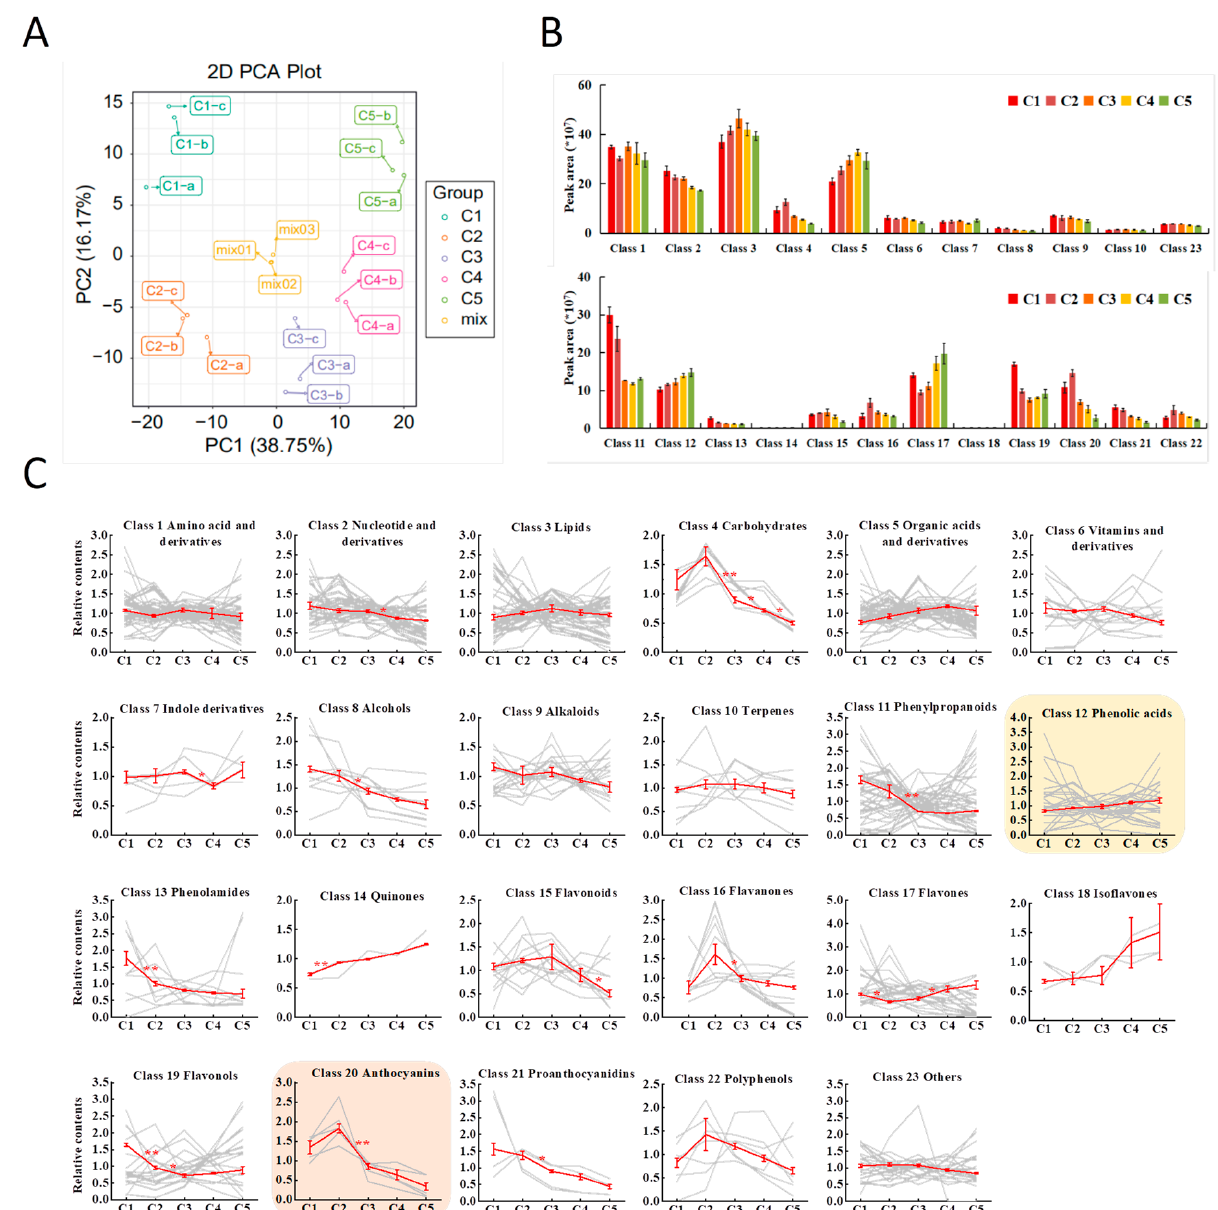
Figure 2. Metabolite accumulation for the 23 classes in leaf stages from C1 to C5. ( A ) PCA analysis of the 449 identified metabolites. Mix 01–03 were the three quality control samples. ( B ) Metabolite abundance of the 23 classes indicated by the added-up peak areas of compounds within each class. ( C ) Relative accumulation trends for compounds of the 23 classes. The trends were reflected by standardized peak areas (mean peak area of each stage/mean peak area of the five stages). Each gray line represents the trend for one individual compound. The red lines represent the combined trends of the compounds from each class. Class 12 (Phenolic acids) and Class 20 (Anthocyanins) were high- lighted by yellow and pink shades, respectively. All values are expressed as means ± SE, n = 3. The significant differences for adjacent stages are indicated by asterisks at p < 0.05 (*) and p < 0.01 (**). Relative accumulation trends for metabolites of the 23 classes were shown by stand- ardized peak areas (mean peak area of each stage/mean peak area of the five stages) (Fig- ure 2C). Within each class, the general trend (shown by the red line) was the same as that in Figure 2B, while the trends of individual compounds (shown by the gray lines) varied greatly. The Class 12 (Phenolic acids, highlighted by yellow shade), containing the main reported functional CQA phenolics, showed a combined upward trend, contrary to the gradual decline in antioxidant activities along leaf development (Figure 1E), possibly due to effects of some individual compounds. For Class 20 (Anthocyanins, highlighted by pink shade), the five individual anthocyanins have similar trends: C2 > C1 > C3 > C4 > C5, with